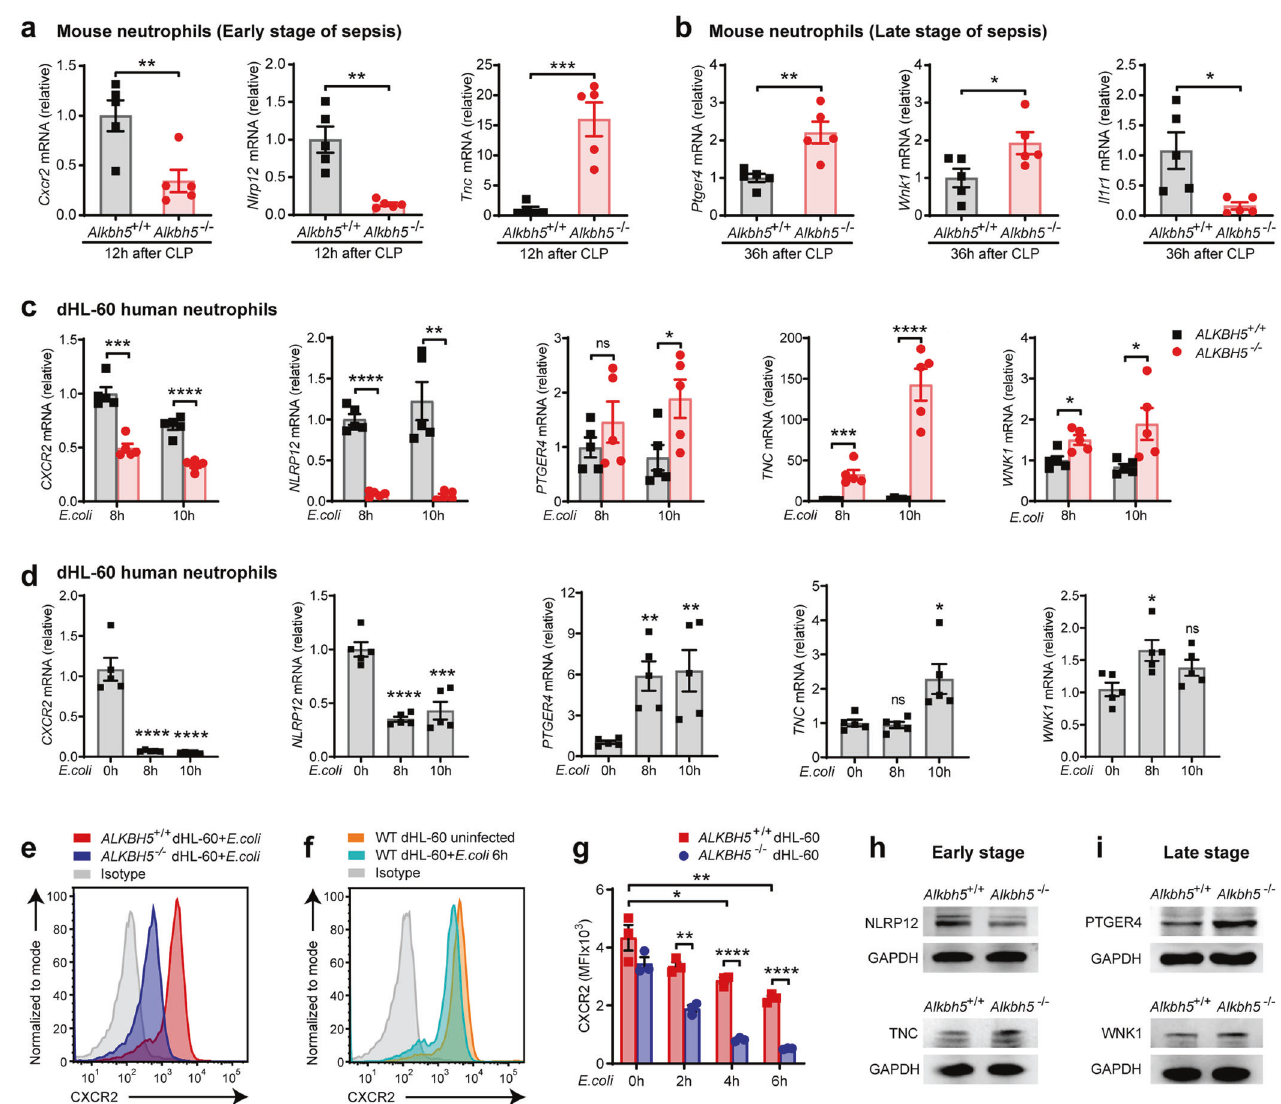
Fig. 5 ALKBH5 selectively enhances migration-promoting molecules but suppresses migration-inhibitory genes in neutrophils. a , b qRT-PCR of the mRNA levels of indicated genes in peritoneal neutrophils isolated from Alkbh5 -de fi cient mice ( Alkbh5 – / – ) and WT littermates ( Alkbh5 + / + ) at 12h ( a ) or 36h ( b ) after mild CLP ( n = 5). c qRT-PCR of the mRNA levels of indicated genes in ALKBH5 -de fi cient ( ALKBH5 – / – ) and WT ( ALKBH5 + / + ) dHL-60 cells infected with E.coli as indicated times ( n = 5). d qRT-PCR of the mRNA levels (relative to 0 h) of indicated genes in WT dHL-60 cells infected with E.coli as indicated times ( n = 5). e FACS analysis of the cell-surface protein-level expression of CXCR2 on ALKBH5 + / + and ALKBH5 – / – dHL-60 cells infected with E.coli for 6 h. f FACS analysis of the cell-surface protein-level expression of CXCR2 on WT dHL-60 cells infected with E.coli or uninfected as indicated. g Quanti fi cation of CXCR2 MFI on indicated dHL-60 cells as in ( e ) and ( f ) ( n = 3). MFI mean fl uorescence intensity. h , i Immunoblot analysis of the protein expression levels of indicated genes in blood neutrophils from Alkbh5 -de fi cient mice ( Alkbh5 – / – ) and WT littermates ( Alkbh5 + / + ) at 12h ( h ) or 36 h ( i ) after mild CLP. All data are mean ± SEM of biologically independent samples. qRT- PCR data were normalized to Gapdh ( a , b ) or GAPDH ( c , d ) expression. Data are representative of 3 independent experiments with similar results [( e , f ) and ( h , i )]. * P < 0.05; ** P < 0.01; *** P < 0.001; **** P < 0.0001; ns not signi fi cant. Two-tailed unpaired Student ’ s t test [( a – d ) and ( g